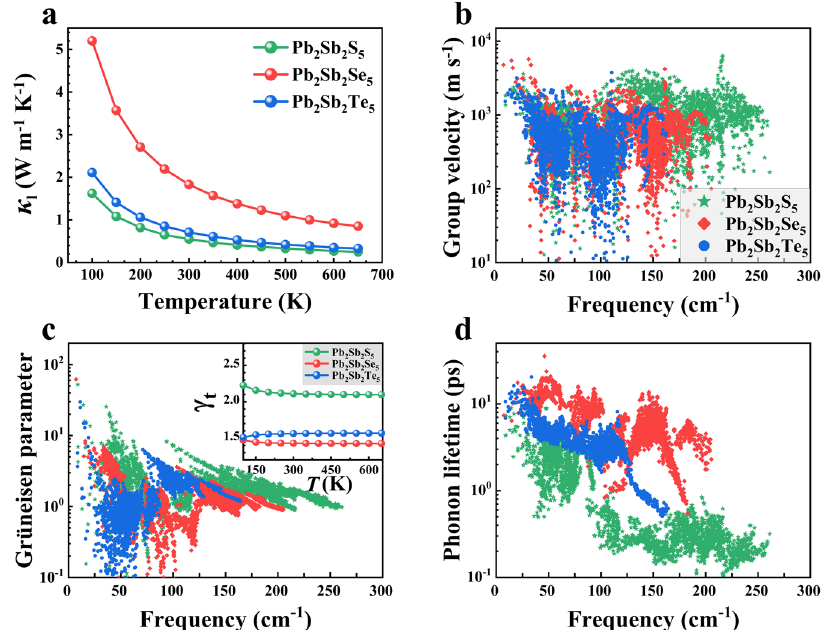
Fig. 8 Lattice thermal conductivity analysis. a Temperature-dependent lattice thermal conductivity, b phonon group velocity, c absolute mode Grüneisen parameter and d room temperature phonon lifetime of Pb 2 Sb 2 S 5 , Pb 2 Sb 2 Se 5 , and Pb 2 Sb 2 Te 5 . The inset of Fig. 8c is the temperature dependence of the total Grüneisen